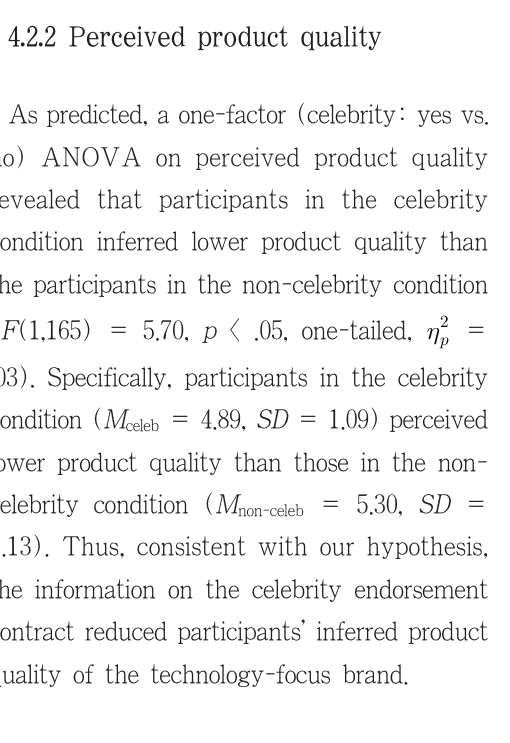
<Figure 2> The Effect of a Celebrity Endorsement Contract Announcement on Perceived